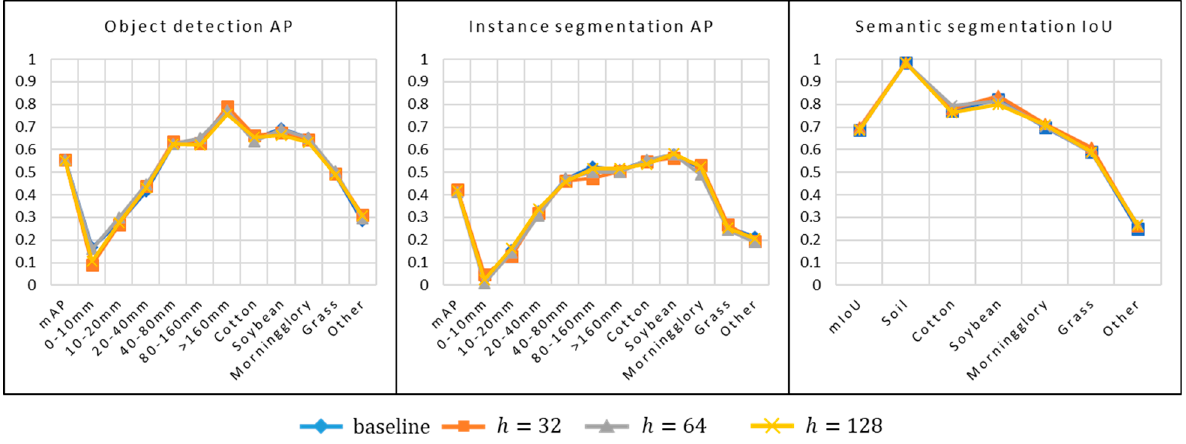
Figure 7. Influence of image denoising on the performance of Faster R-CNN for object detection, of Mask R-CNN for instance segmentation, and of Deeplab-v3 for semantic segmentation.